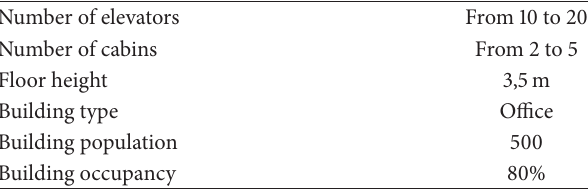
Figure 8: Calls according to number of floors. Table 2: Building parameters.